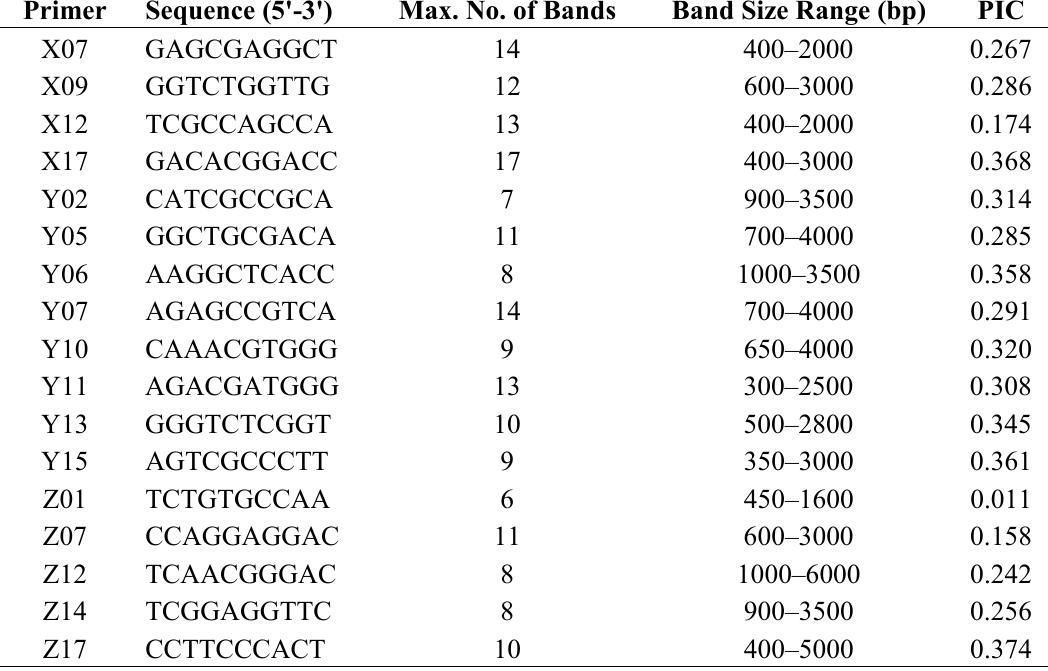
Table 2. Description of oligonucleotide primers used for random amplified polymorphic DNA (RAPD)